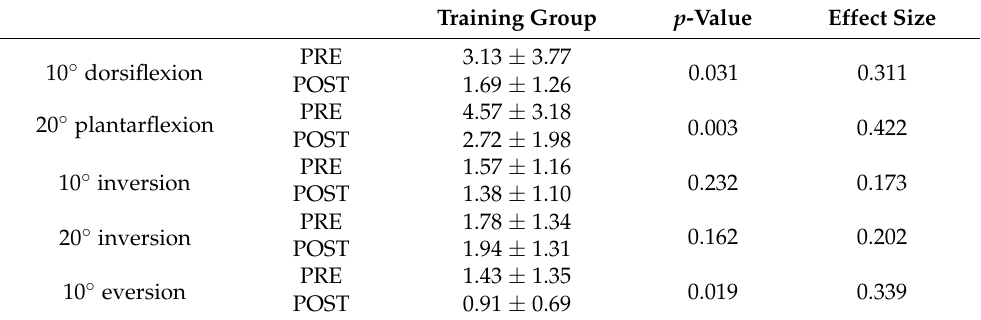
Table 3. Mean ± SD of absolute error of active joint reposition sense in dominant-leg ( ◦ ).